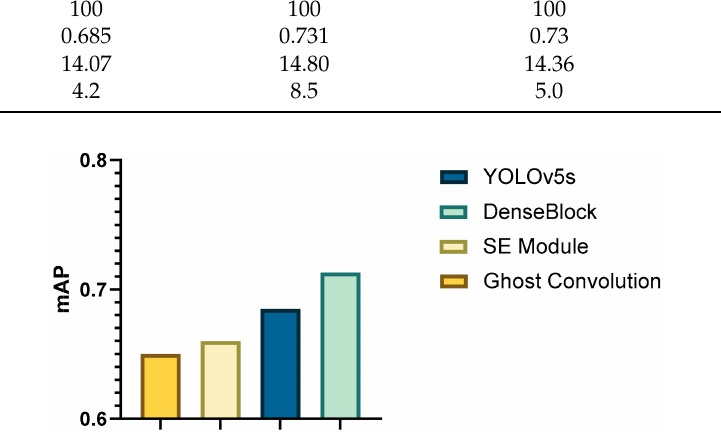
Figure 17. Single-module mAP histogram.